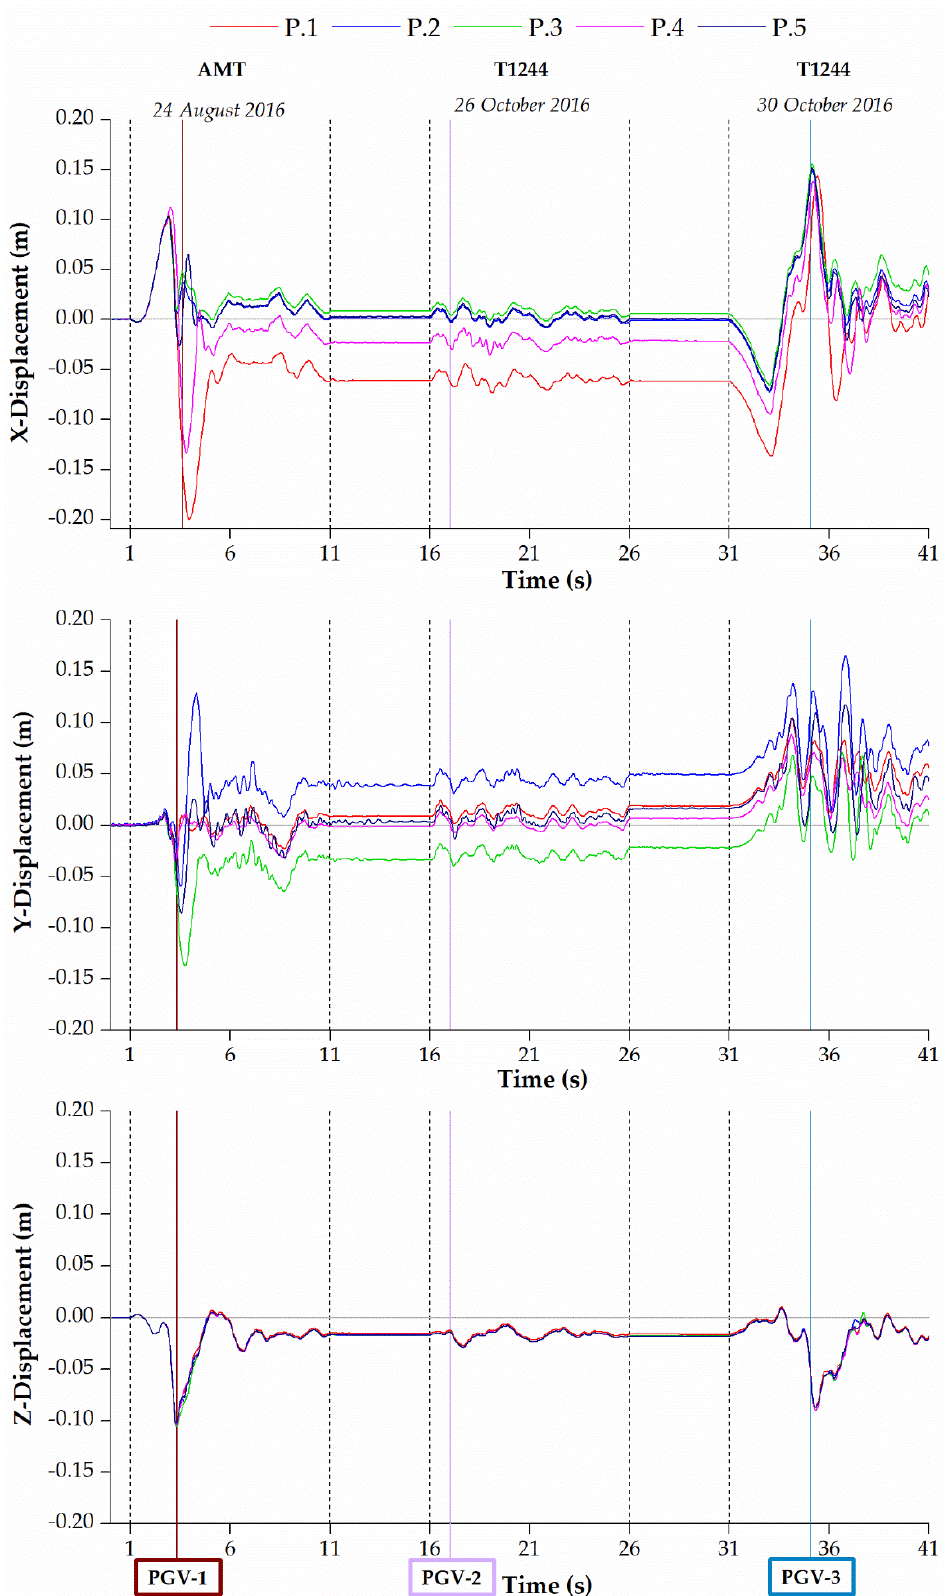
Figure 11. Displacements THs in the x, y, and z directions of the five church monitoring points calculated with nonlinear dynamic analyses by means of the NSCD method under the seismic actions near the church.